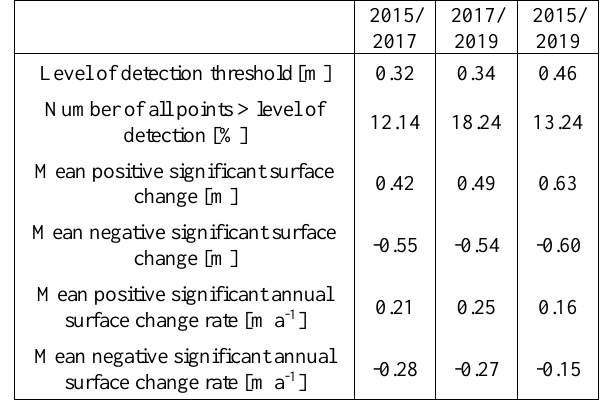
Table 5. Surface changes detected with